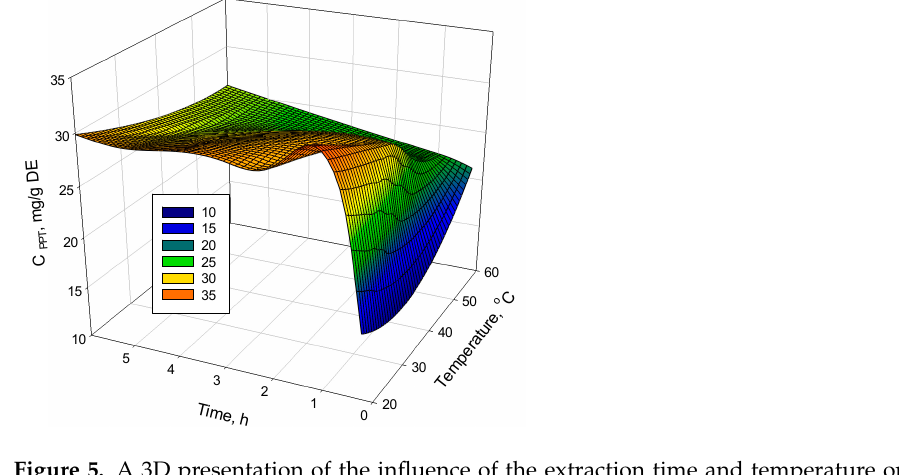
Figure 5. A 3D presentation of the influence of the extraction time and temperature on the PPT content (mg/g DE) in J. virginiana leaf extracts, obtained at normal pressure under agitation (shaker water bath).